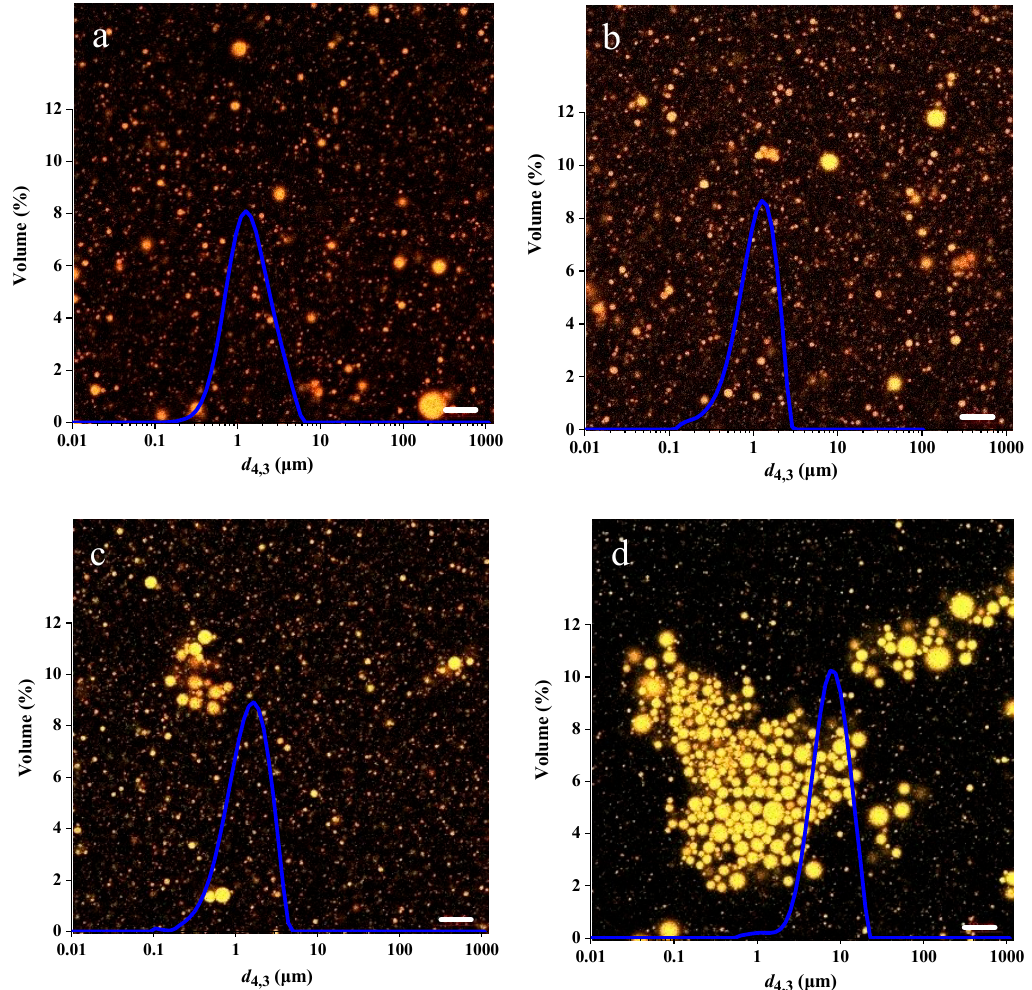
Figure 6. Influence of thermal treatment on the particle-size distribution and CLSM of PSP-stabilized emulsions. ( a ) the control (emulsion without thermal treatment), ( b – d ) emulsions with thermal treatment at 70 °C, 80 °C, 90 °C for 30 min, respectively. Scale bar in the micrographs corresponds to 10 μ m. Values are means ± SDs (n = 3).